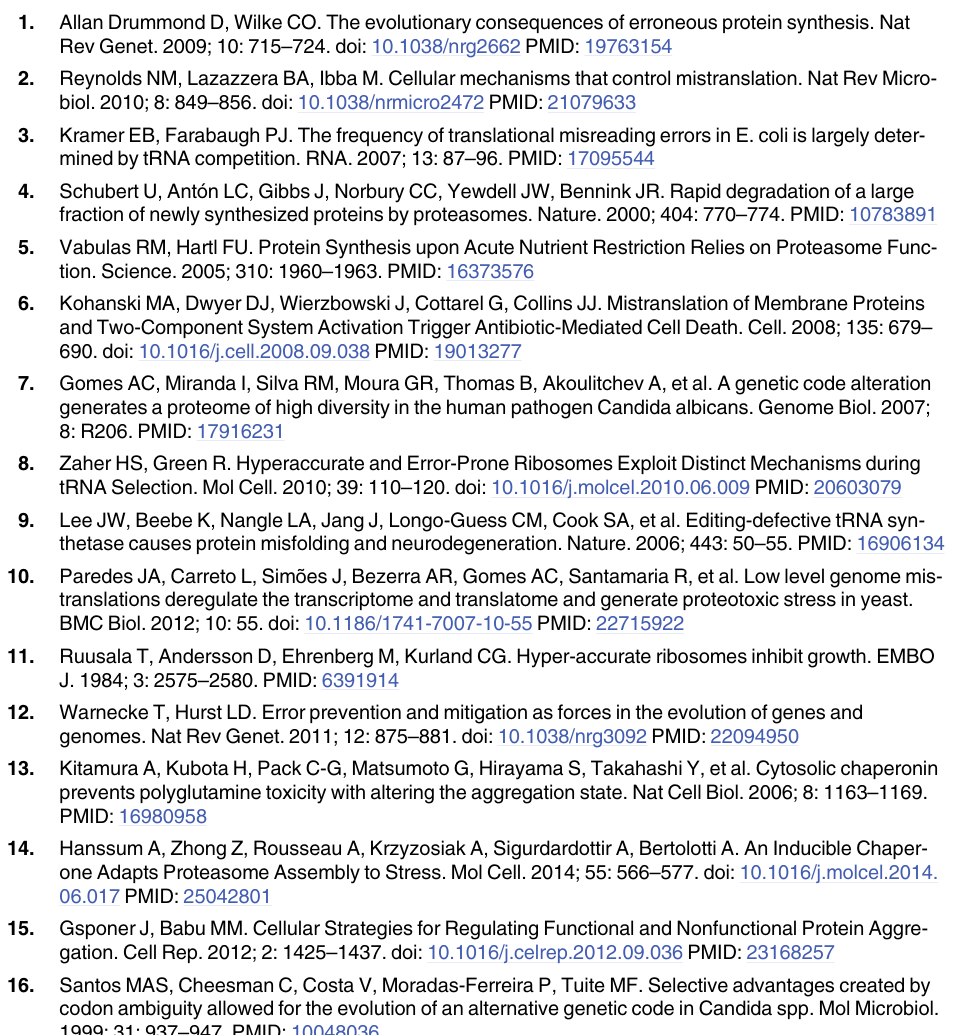
S4 Table. SNPs found in tS(AGA)D3, a serine-coding